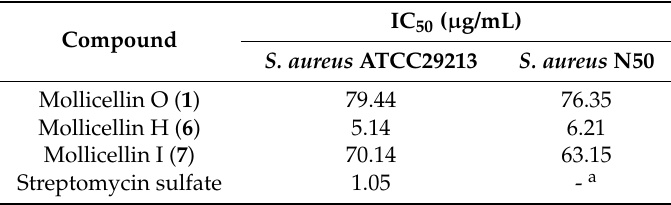
Table 3. Antibacterial activities.